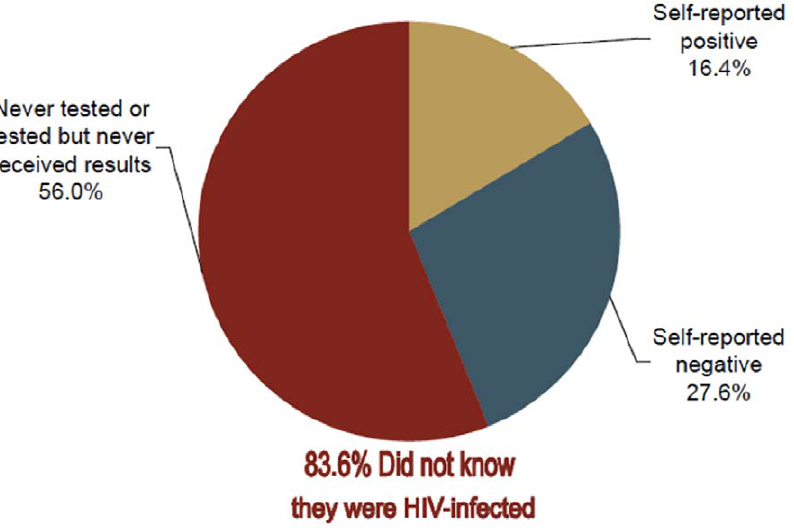
Figure 1. Awareness of HIV status and testing history among HIV-infected persons, Kenya AIDS Indicator Survey 2007. doi:10.1371/journal.pone.0036797.g001 PLoS ONE |